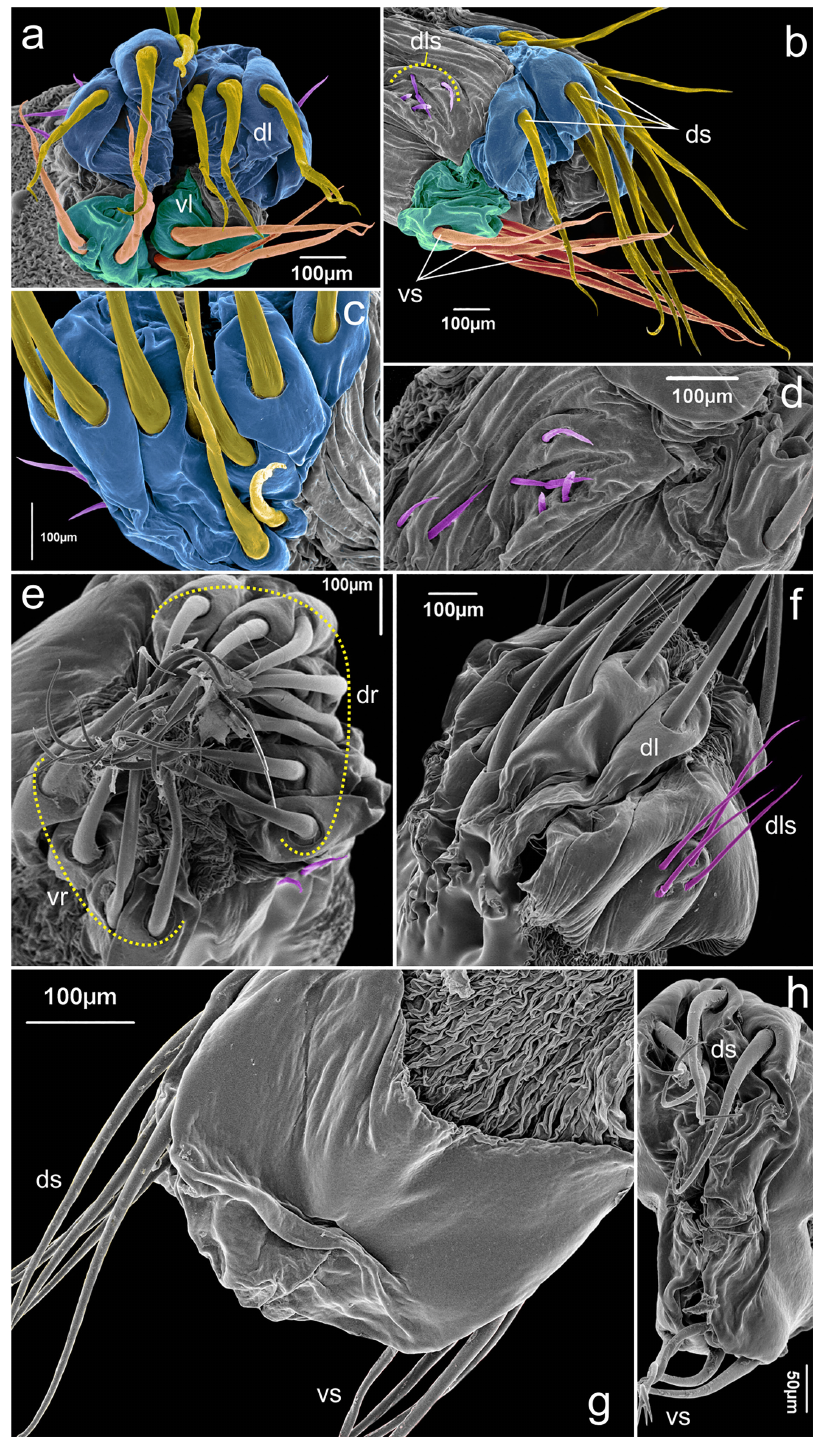
Fig. 7. Distal portion of the ovipositor, colorized to show structures as defined here. See text for more details. — a – d . Phalangodus briareos sp. nov. (MNRJ 2163). a . Distal view. b . Latero-distal view. c . Dorso-distal view. d . Detail of dorso-lateral group of microsetae. — e–f . Phalangodus gyes sp. nov. (MNRJ 17907). e . Distal view. f . Latero-dorsal view. — g–h . Phareicranaus hermosa Pinto-da-Rocha & Kury, 2003 (UFMG 9223). g . Lateral view. h . Distal view. Abbreviations: see Material and